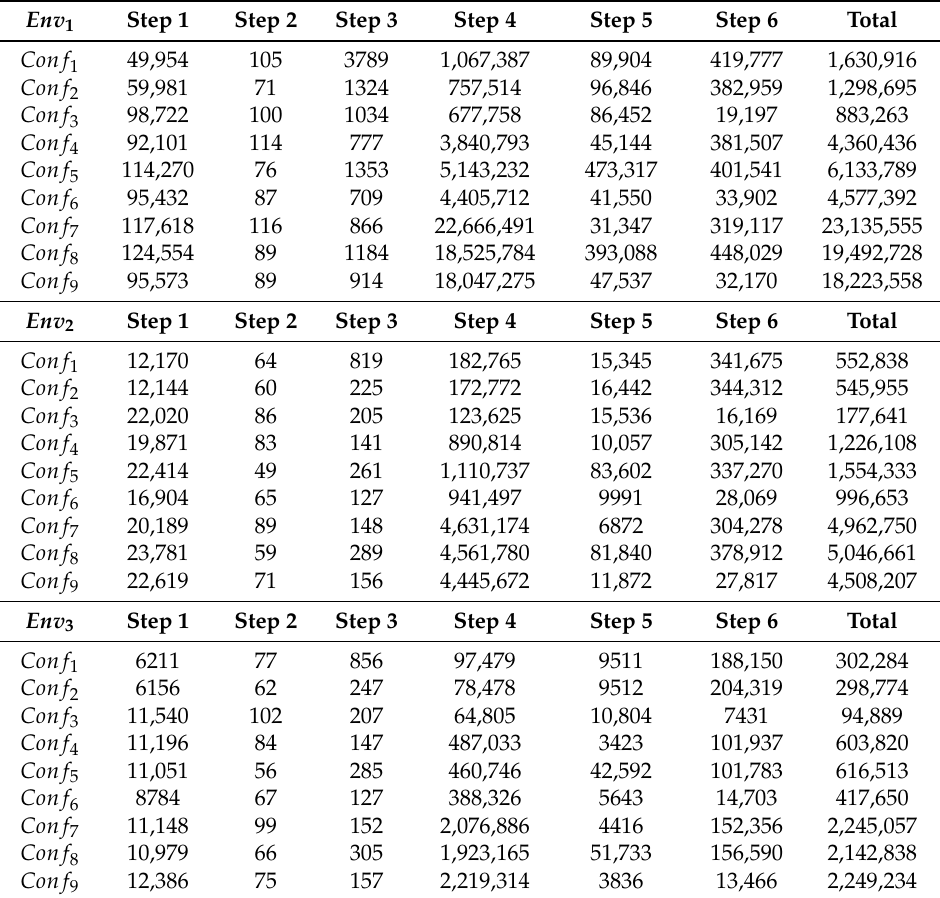
Table 5. Execution times for the corpus of 1000 data sets (first Map-Reduce